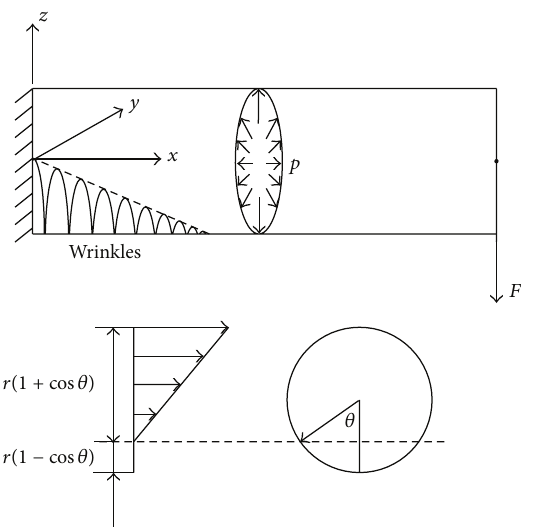
Figure 5: Analytic model of the inflatable cantilever tube.